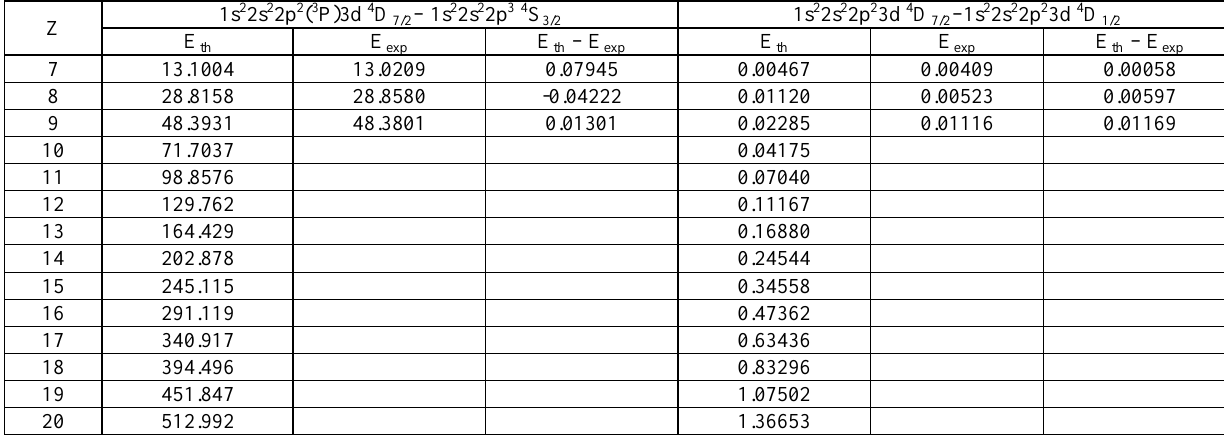
Table 9. Comparison of the calculated energies (in eV) of 1s 2 2s 2 2p 2 ( 3 P)3d 4 D 7/2 – 1s 2 2s 2 2p 3 4 S 3/2 and 1s 2 2s 2 2p 3 4 S 3/2 states